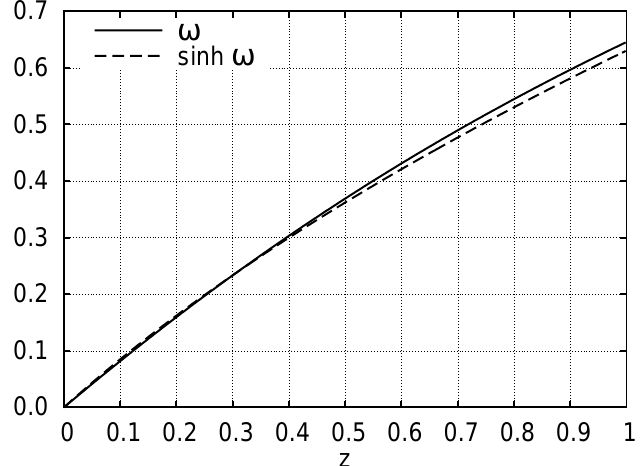
Fig. 1a. The run of the angular variable ! for the flat model universe with cosmo- logical constant (solid curve) and sinh ! for a hyperbolic universe (dashed curve) versus the redshift. The difference of curves is rather small.